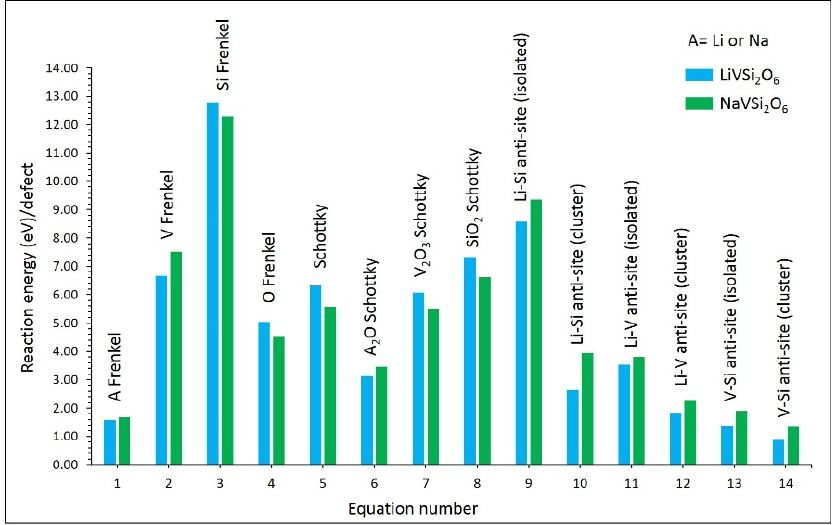
Figure 2. Intrinsic defect energies in LiVSi 2 O 6 and NaVSi 2 O 6 .